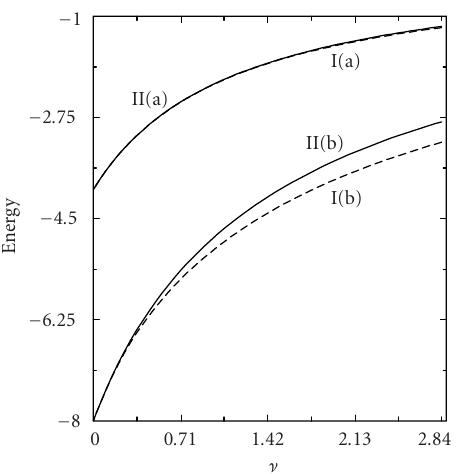
Figure 4.8. The variation of the energy of unstaggered stationary localized states as a function of ν for two values of a and for two permissible values of x 0 . Of course, the result is obtained from the exact calculation with (cid:7) H 0 = constant. For curves I(a) and II(a), a = 1 . 0, but x 0 = 0 . 0 and 0 . 5, respectively. For curves I(b) and II(b), a = 2 . 0, but x 0 = 0 . 0 and 0 . 5,